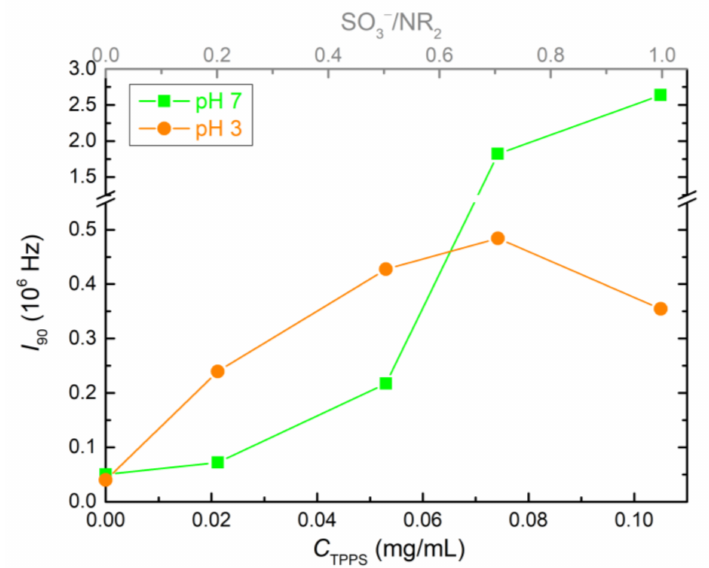
Figure 1. DLS intensity values at 90 ◦ I 90 for the DHBC/TPPS complex solutions at pH 7 and 3, as a function of porphyrin concentration C TPPS or charged groups ratio SO 3 − /NR 2 (R = CH 3